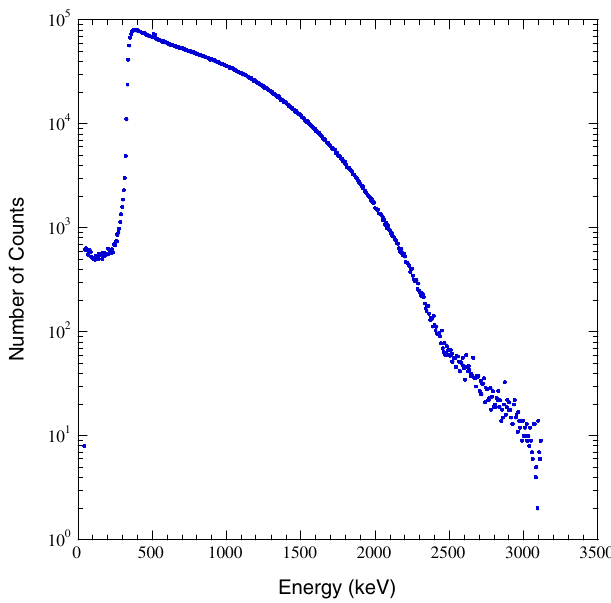
FIG. 7. Plot of photon counts versus energy at the highest power level showing the transition from single-photon events to two-photon events at 2.5